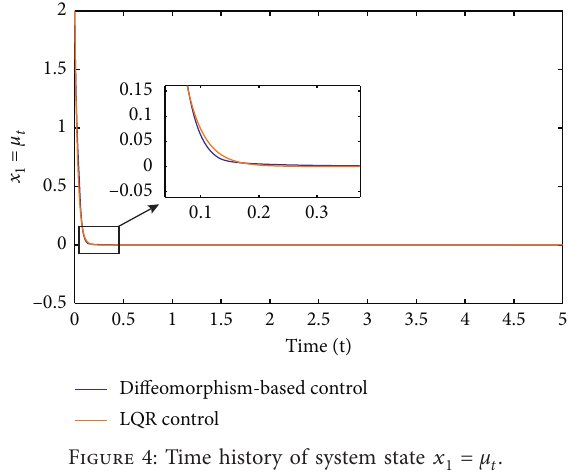
Figure 4: Time history of system state x